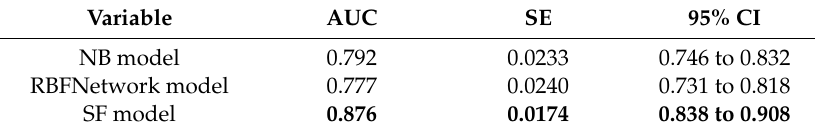
Table 3. Parameters of ROC curves with the validation